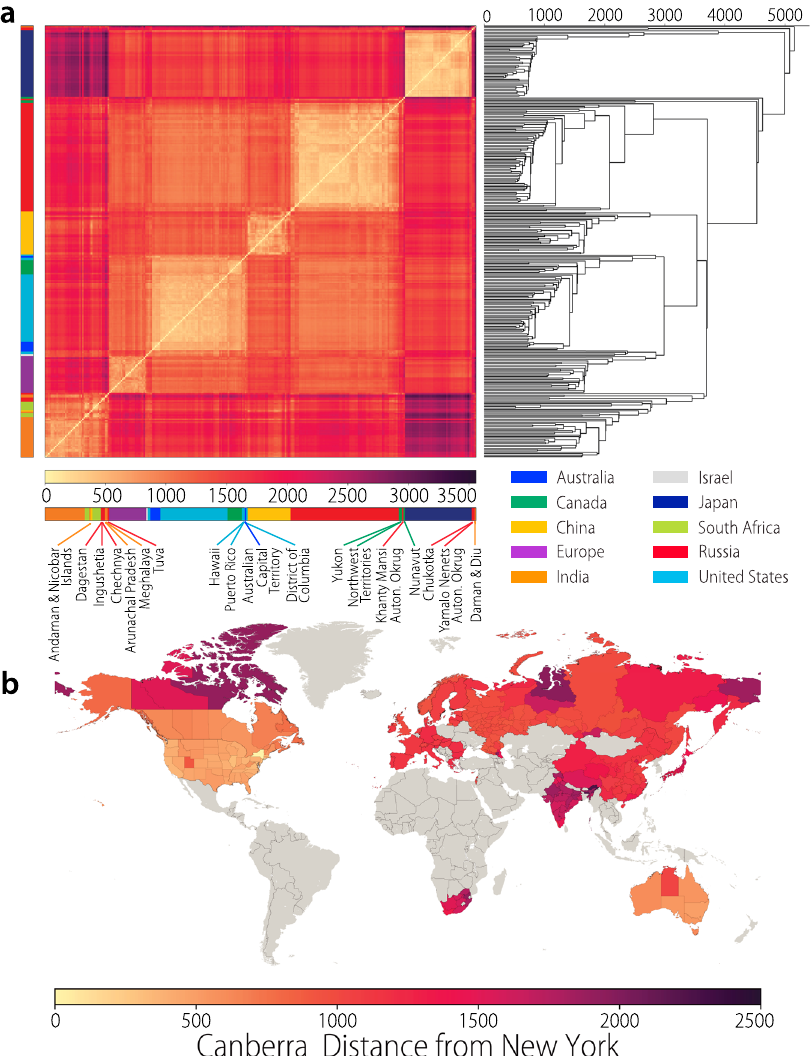
Fig. 5 Clustering of contact matrices. a Clustered matrix of the Canberra distance between subnational contact matrices and associated dendrogram using hierarchical clustering to organize subnational locations. Lighter colors indicate locations more similar to each other (distance closer to 0). b World map of the subnational level where colors represent the Canberra distance between each subnational location and the US state of New York (used as a reference point). The gray color means that no data is available. Note that the country of Israel is treated at the national level, rather than the subnational level, due to both its relatively small population and area, and the resolution of data available for